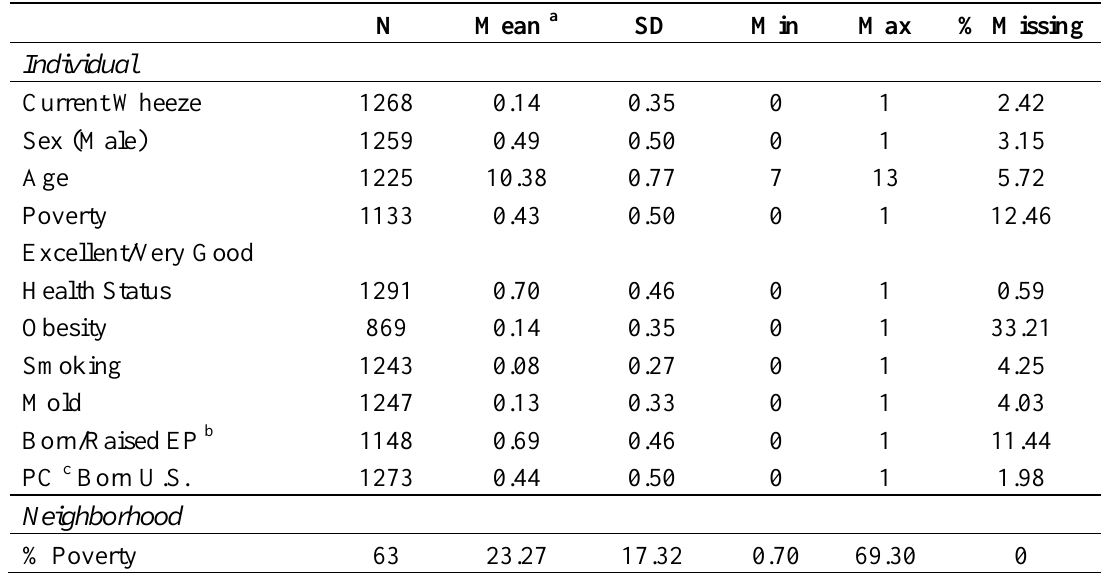
Table 2. Descriptive statistics of analysis